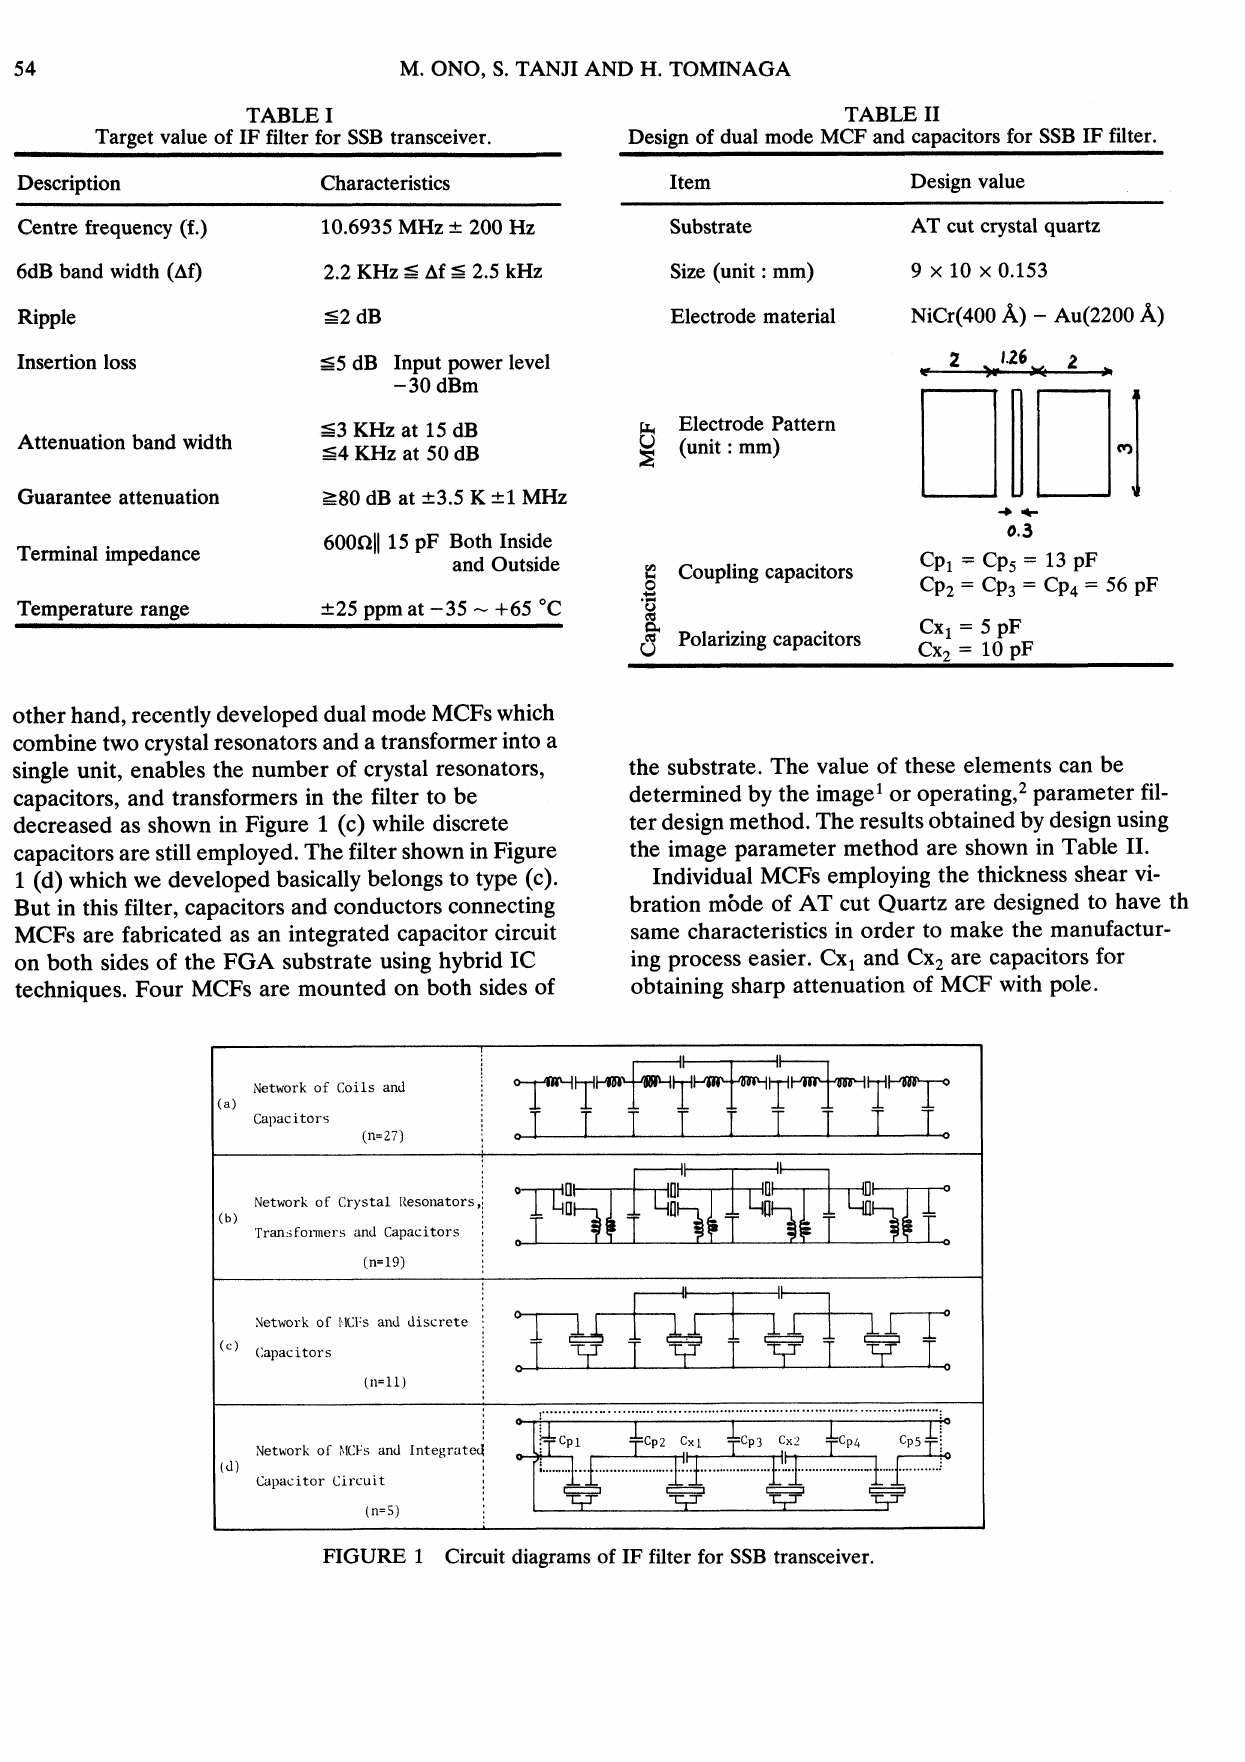
FIGURE Circuit diagrams of IF filter for SSB